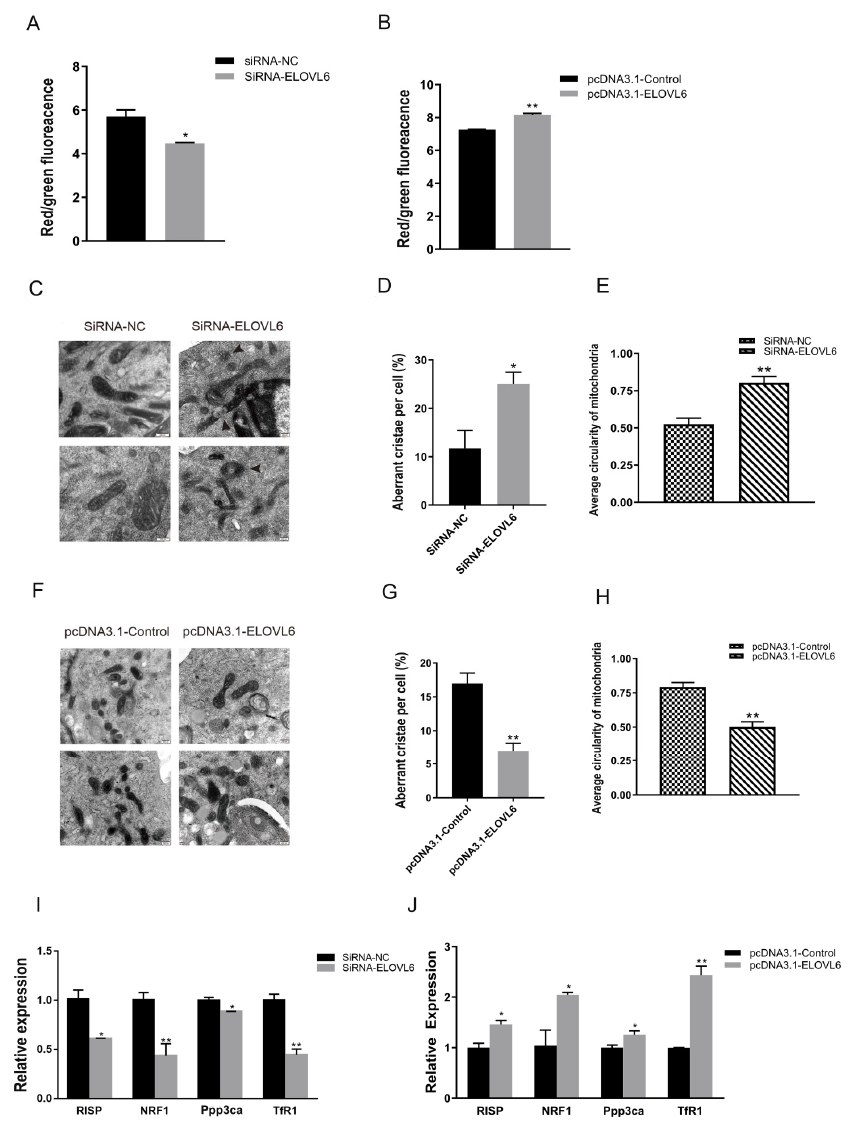
Figure 5. ELOVL6 affects the mitochondrial morphology in C2C12 cells. ( A ) The mitochondrial membrane potential in C2C12 cells was detected by JC-1 following transfection with siRNA-ELOVL6 or negative control (NC). ( B ) The mitochondrial membrane potential in C2C12 cells was detected by JC-1 following transfection with pcDNA3.1 ELOVL6 or pcDNA3.1 control. ( C ) Mitochondrial morphology was observed by transmission electron microscopy (TEM) following transfection with siRNA-ELOVL6 or NC. The black arrow shows an abnormal crista of the mitochondria. ( D ) The percentage of mitochondria with abnormal cristae in each cell was calculated. ( E ) The average circularity of mitochondria was calculated. Scale bar, 200 nm. ( F ) Mitochondrial morphology was observed by TEM following transfection with pcDNA3.1 ELOVL6 or pcDNA3.1 control. ( G ) The percentage of mitochondria with vacuoles and abnormal cristae in each cell was calculated. ( H ) The average circularity of mitochondria was calculated. ( I ) The expression of mitochondrial function- related genes in C2C12 cells following transfection with siRNA-ELOVL6 or NC. ( J ) The expression of mitochondrial function-related genes in C2C12 cells following transfection with pcDNA3.1 ELOVL6 or pcDNA3.1 control. * p < 0.05, ** p < 0.01. Data represent mean ± SEM from at least three independent